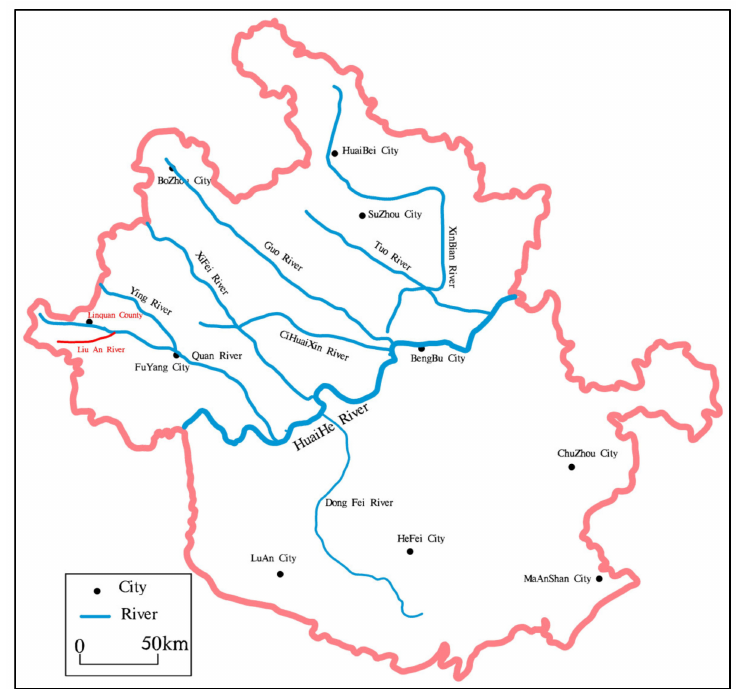
Figure 2. Map of the Huaihe River drainage